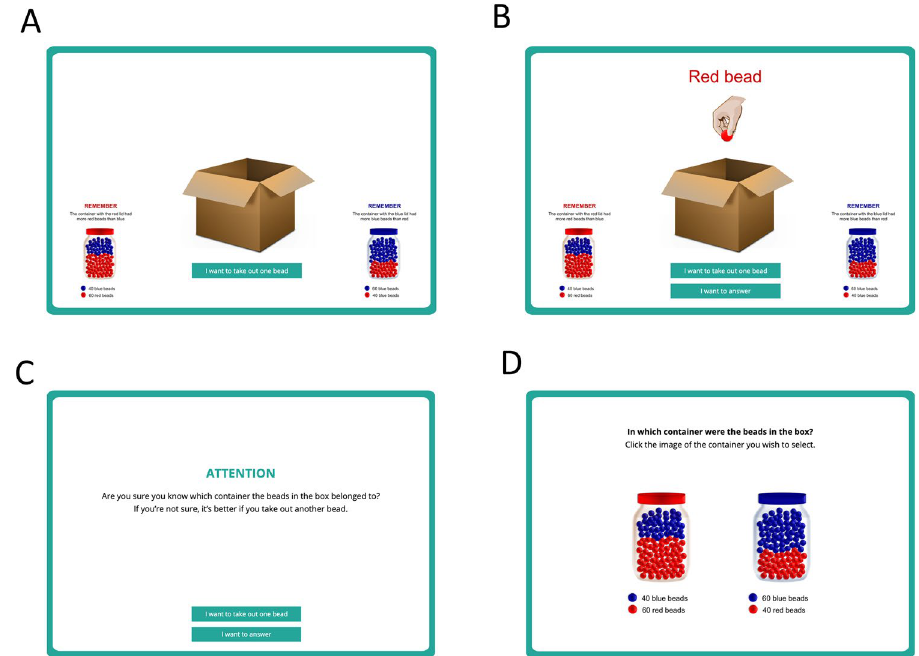
Figure 3. Beads task. Panel (A) displays how information was presented on the first trial. Note that participants are forced to take the first bead. The remaining 49 trials allow participants to take an additional bead or to give an answer, see Panel (B) . Panel (C) shows the confirmation screen. Finally, panel (D) displays how the final choice between containers was